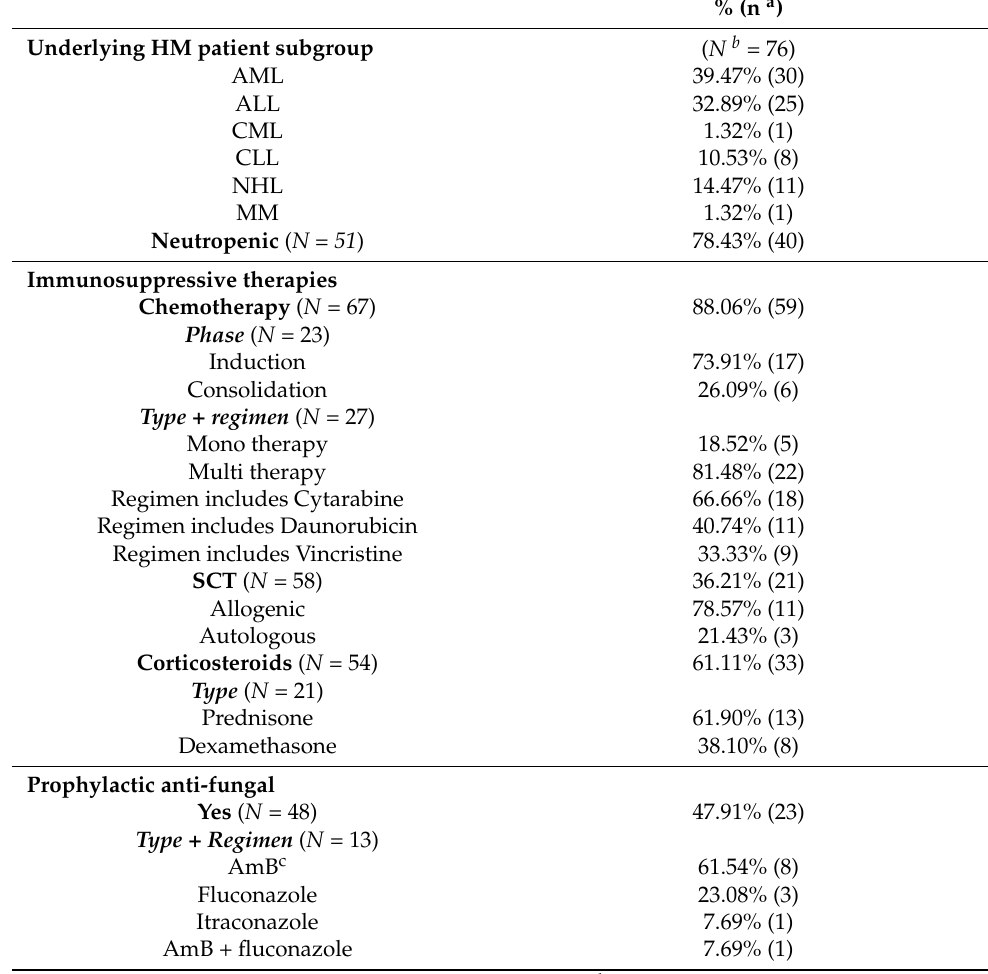
Table 3. Patient